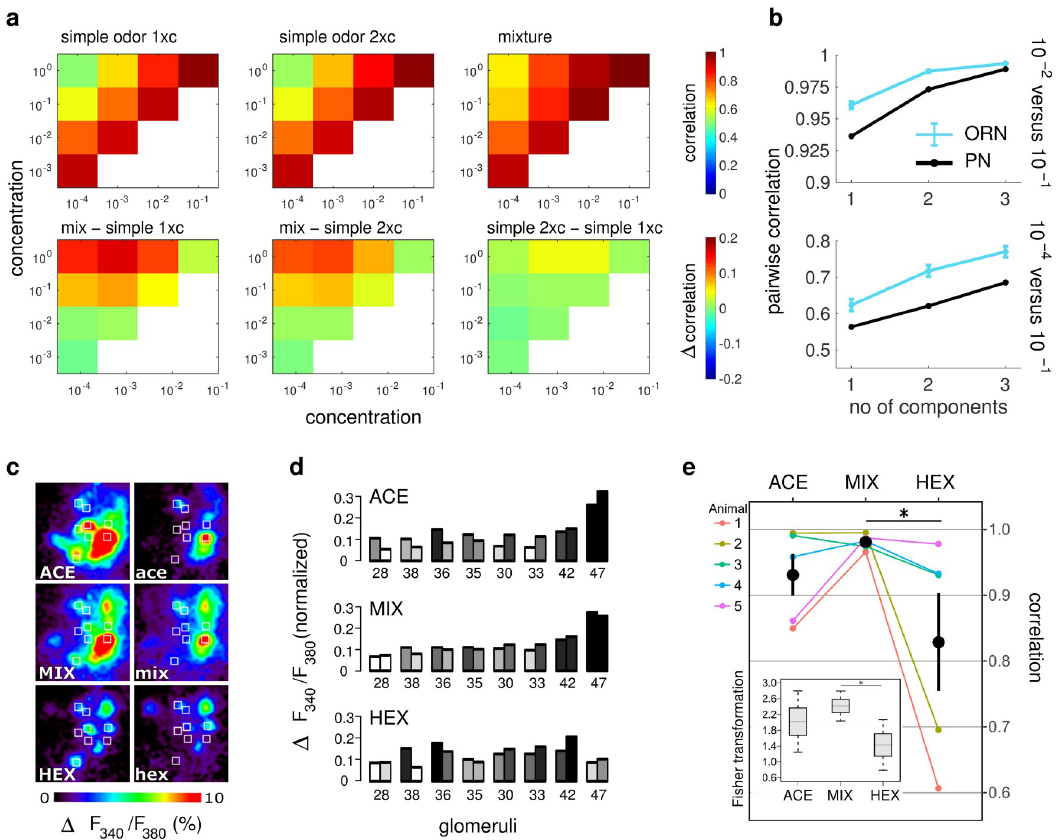
Fig 4. Pattern stability across concentrations for single odorants and mixtures. ( a ) Pearson’s correlation coefficients for ORN response patterns across various concentrations for single odorants and binary mixtures predicted by our AL model using constrained parameters as described in the Methods. They are calculated by averaging over all odorants in our model and over 1000 trials. Top panels from left to right: Correlation of a single odorant with itself, correlation of a single odorant with itself at twice the concentration, correlation of the mixture with itself; bottom row: differences in the corralations in the top row, between single odorant and mixture, between single odorants at twice the concentration and mixture, and between single odorant and single odorant at twice the concentration. The cross-concentration correlations for binary mixtures are higher. ( b ) Pearson’s correlation coefficients for ORN and PN response patterns at a low concentration ( c = 3 � 10 − N for single odorants; 1.5 � 10 − N for binary mixtures;10 − N for ternary mixtures. Top: N = -2; Bottom: N = -4) and a high concentration ( c = 3 � 10 − 1 for single odorants; 1.5 � 10 − 1 for binary mixtures; 10 − 1 for ternary mixtures) as predicted by our AL model. Concentrations were chosen so that the stimuli contained the same number of molecules each. Correlations were calculated as in a except that the results for PNs are from a single trial. The error bars for ORNs are the standard deviation across different trials. The correlation increases with the number of components in the stimuli for both ORN and PN. ( c ) Average AL response over 1.5s after odor onset of a representative animal as measured by calcium imaging. Left and right panels correspond to high and low concentrations respectively (one order difference). ACE: acetophenone; HEX: hexanol and MIX: mixture of ACE and HEX at 1:1 ratio. White squares mark the identified glomeruli used for the analysis. ( d ) Normalized activity elicited by odors at low and high concentrations (left and right columns in each pair). The gray scale used for the columns indicates the order of the glomeruli ranked according to the magnitude of their responses (lowest responding glomerulus: white; highest: black). The response pattern for mixtures is more stable than for both of its components, as illustrated by, in general, the higher similarity in height and color tone within each pair of bars ( e ) Pearson’s correlation coefficients between response patterns elicited by low and high odor concentrations. The correlation coefficients were calculated among patterns obtained by averaging three replicate measurements. Colored lines correspond to data of 5 bees. Black circles and error bars correspond to mean and SEM of the 5 bees. Statistical analysis (Wilcoxon one-sided signed rank test) was based on Fisher transformed correlation values (N bee = 5; acetophenone-mixture, p = 0.16; 1-hexanol-mixture p = 0.03).